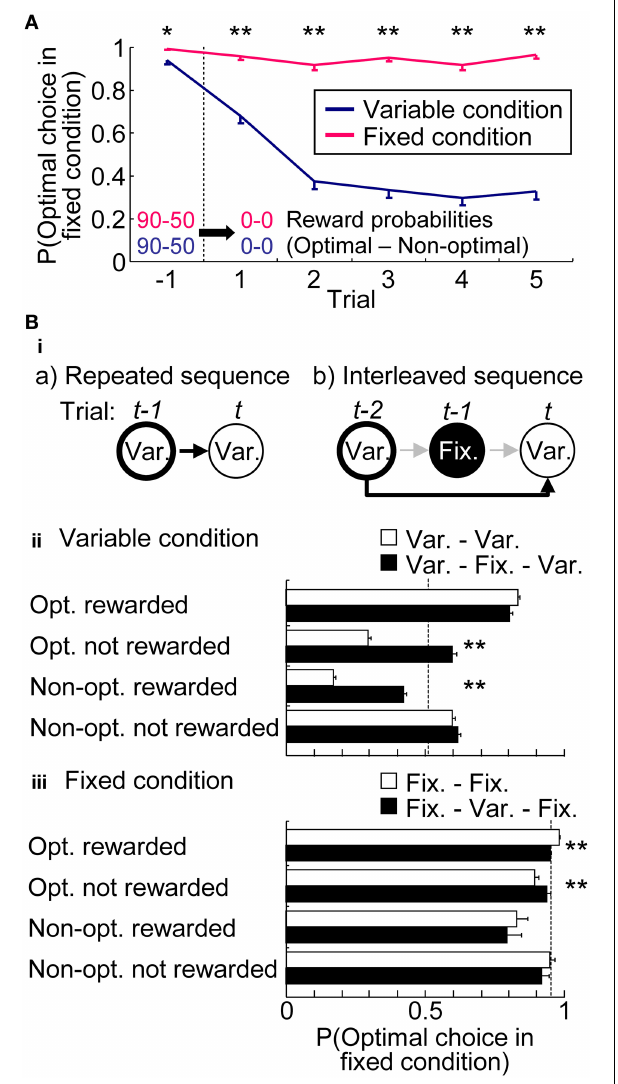
FIGURE 4 | Choices in variable- and fixed-reward conditions. (A) Extinction phase. Probabilities of the optimal choice were quantified before and during extinction-phase trials, which were introduced in the variable- and fixed-reward conditions. Means and standard errors are shown. Before the extinction phase, reward probabilities of variable- and fixed-reward conditions were identical: ∗ p < 0 . 05; ∗∗ p < 0 . 01 in a Mann–Whitney U -test. (Bi) Example of a conditional-probability calculation in repeated (a) and interleaved sequences (b). Depending on the action-outcome experience at trial t -1 for (a) and trial t -2 for (b), the conditional probability at trial t was analyzed. In these examples, the conditional probability of variable-reward-condition trial (Var.) was analyzed, based on the action-outcome experience in the last and the next-to-last trial with a variable-reward condition in (a) and (b), respectively. In (b), the experience in the interleaved trial t -1 with the fixed-reward condition was ignored. Action-outcome experiences had 4 types: optimal choice rewarded (Opt. rewarded); optimal choice not rewarded (Opt. not rewarded); non-optimal choice rewarded (Non-Opt. rewarded); non-optimal choice not rewarded (Non-opt. not rewarded). If the choices of variable- and fixed-reward conditions were independently learned, the conditional probabilities of repeated and interleaved sequences became the same. (ii,iii)